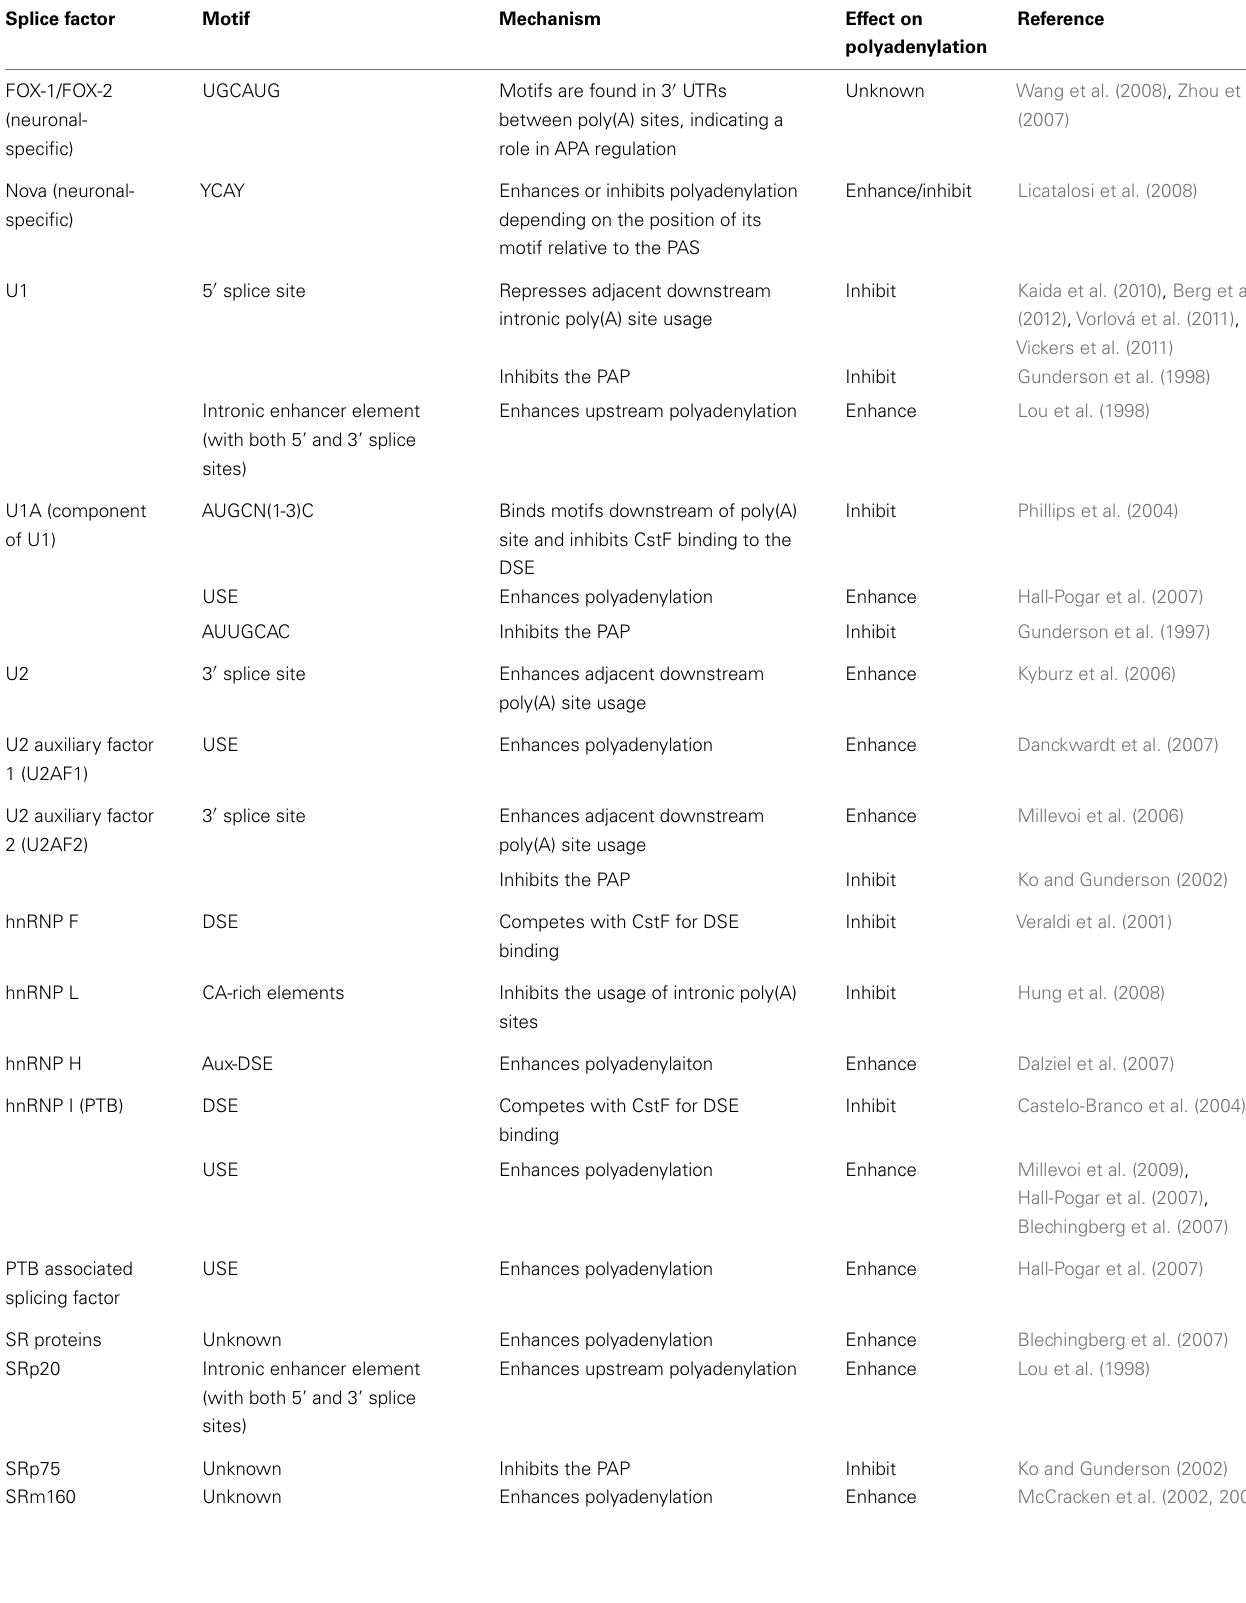
Table 2 | Splice factors affecting